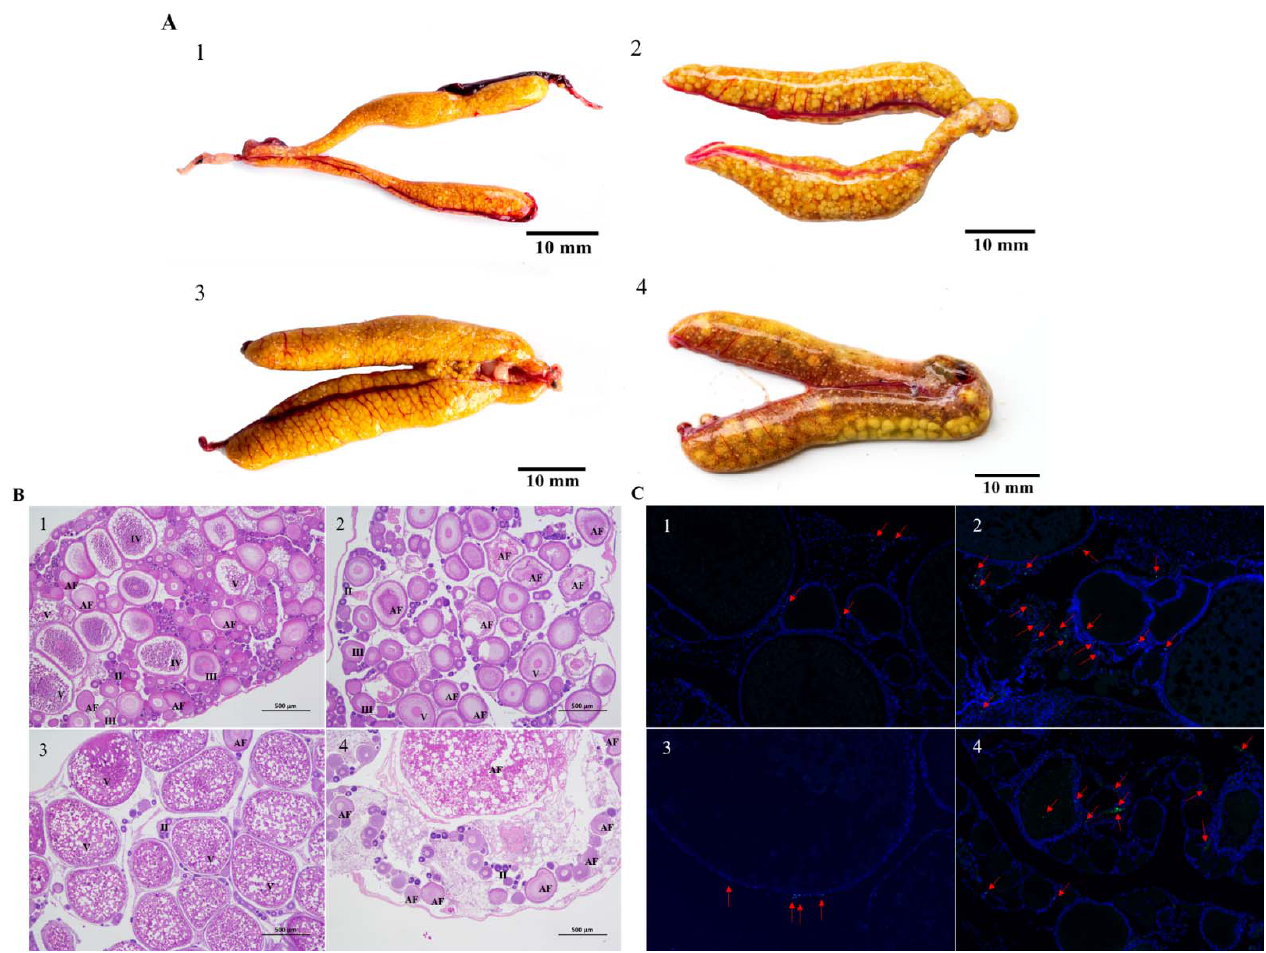
Figure 1. The gonadal status of Nile tilapia ( Oreochromis niloticus ) under heat stress. Note: ( A ) 1–4: Morphological changes of Nile tilapia ovary. ( B ) 1–4: Oocyte development of Nile tilapia ovary (magnification ×40, scale bar: 500 μ m). II, III, IV, and V: stages II, III, IV, and V oocytes, respectively; AF: atretic follicles. Stage II oocytes, early perinucleolar oocytes; stage III oocytes, late perinucleolar oocytes; stage IV oocytes, vitel-logenic oocytes; stage V oocytes, maturing oocytes. ( C ) 1–4: Granulosa cell apoptosis of Nile tilapia ovary (magnification × 100, scale bar: 200 µ m). Red arrows indicate apoptotic granulosa cells. a and c correspond to the control group (CG) on days 6 and 12, respectively; b and d correspond to the heat-stressed group (HG) on days 6 and 12,